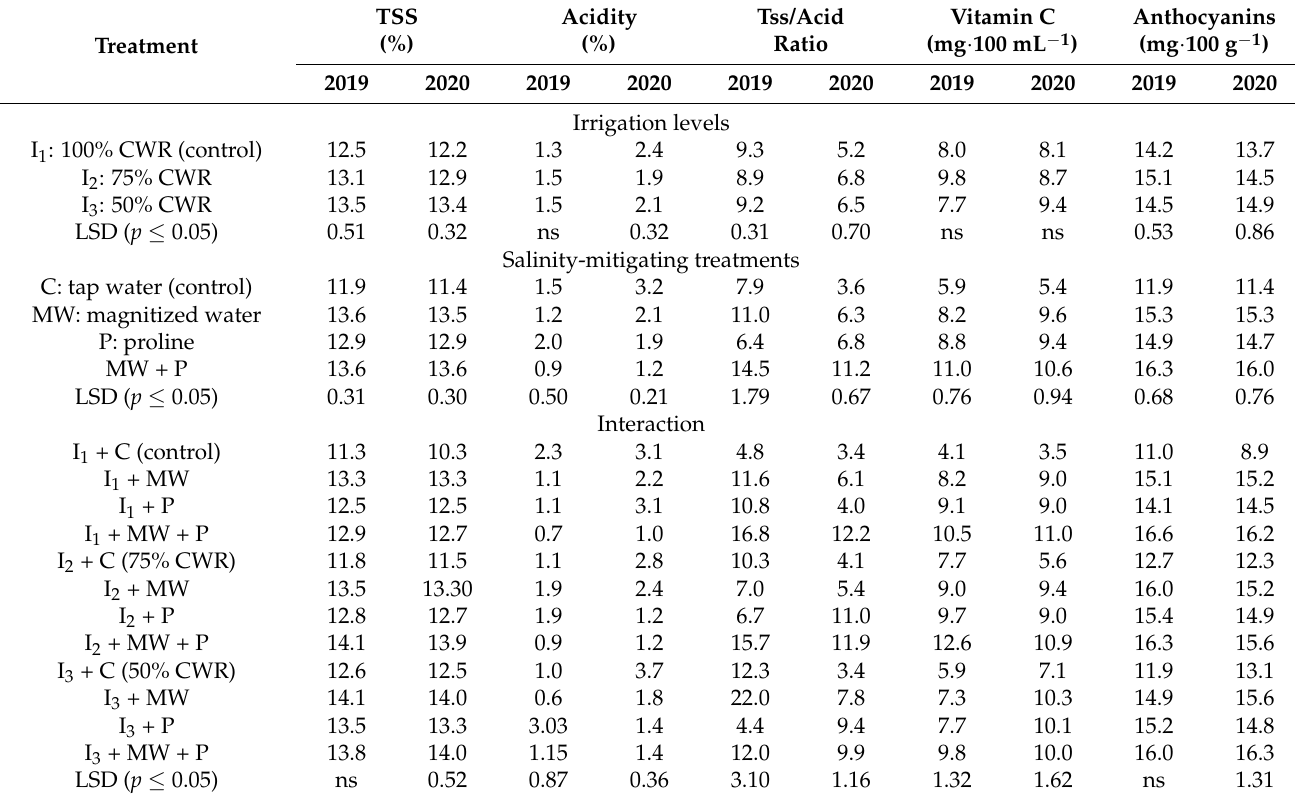
Table 7. Effect of MW, P, and MW + P on fruit chemical characteristics of “Taifi” pomegranate shrubs grown under different irrigation regimes (I 1 , I 2 , and I 3 ), based on CWR, during the 2019 and 2020